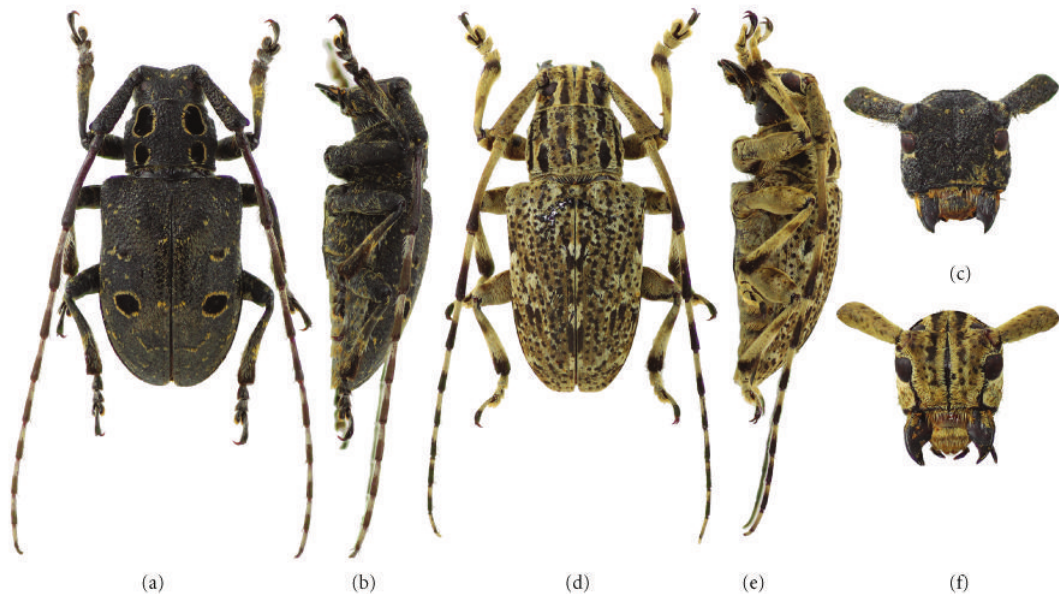
Figure 1: Comparison of the type species of Mesosa ( Mesosa ) and Agelasta ( Dissosira ). (a–c) M. ( M. ) curculionoides ; (d–f) A. ( D. ) catenata ; (a, d) male habitus in dorsal view; (b, e) ditto in lateral view; (c, f) ditto in frontal view.